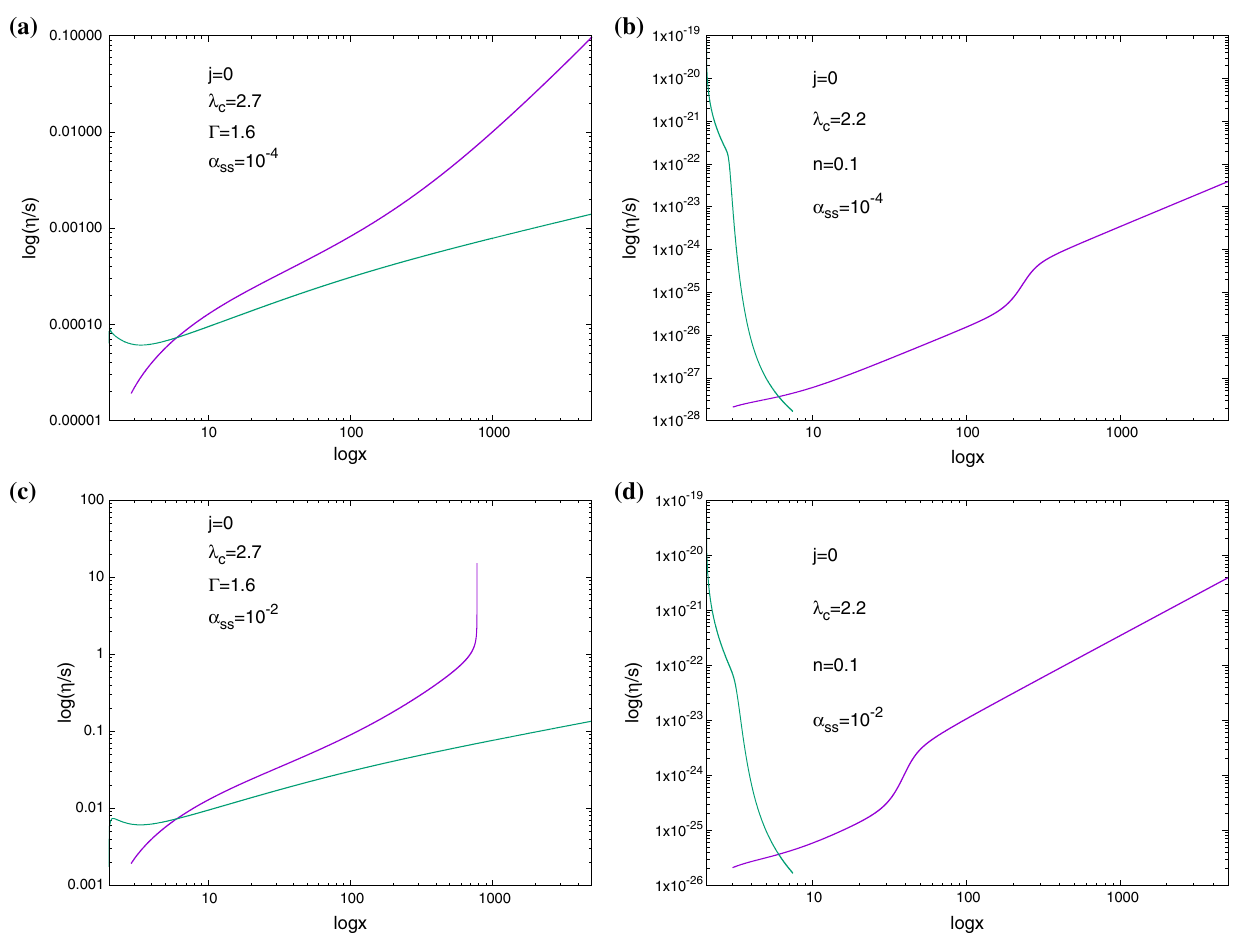
) vs log ( x ) for viscous accretion disc log ( x ) for viscous accretion disc flow with viscosity α ss = 10 − 4 and Fig. 1 a and c are plots of log ( η s α = 10 − 2 respectively, around a non-rotating BH for MCG. Accre- flow with viscosity α ss = 10 − 4 and α ss = 10 − 2 respectively, around ss ) vs tion and wind curves are depicted by purple and green lines a non-rotating BH for adiabatic case. b and d are plots of log ( η s